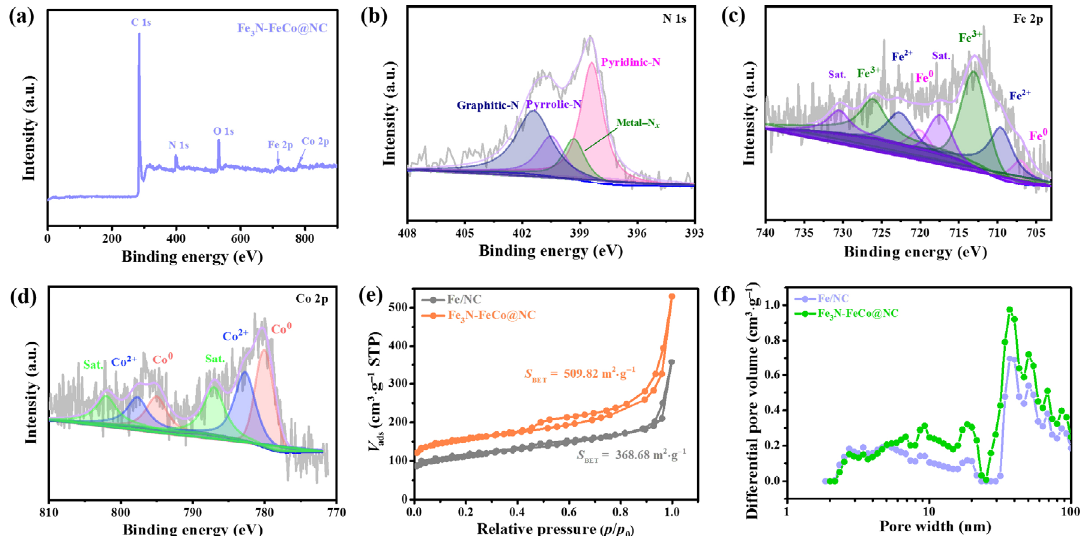
Figure 3 (a) XPS survey spectrum and deconvoluted XPS spectra ((b) N 1s, (c) Fe 2p, and (d) Co 2p) of Fe 3 N-FeCo@NC. (e) N 2 adsorption–desorption isotherms and (f) pore size distribution of Fe 3